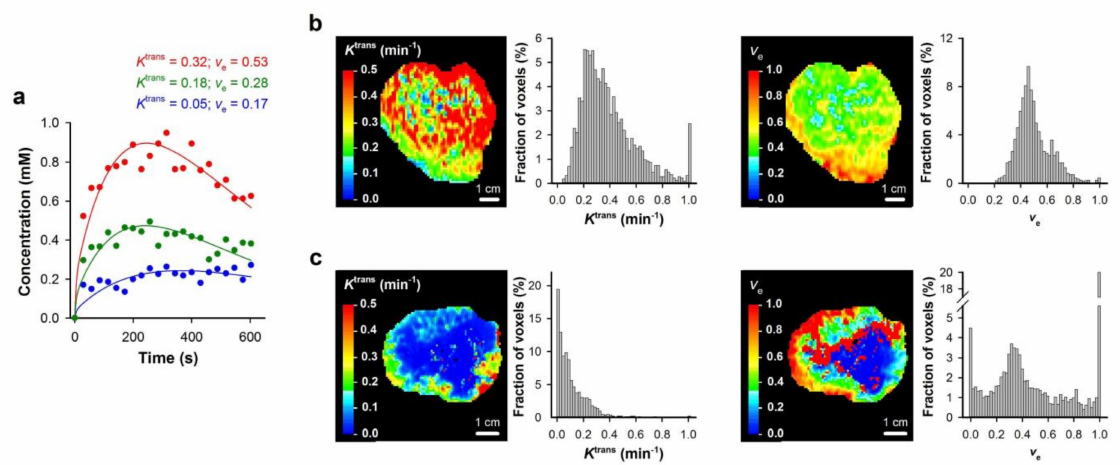
Figure 8. DCE-MRI series of human tumors were analyzed on a voxel-by-voxel basis by using Tofts standard pharmacokinetic model and a population-based arterial input function. ( a ) Plots of Gd-DTPA concentration versus time and the corresponding pharmacokinetic model fits for individual voxels. ( b , c ) K trans image, K trans frequency distribution, v e image, and v e frequency distribution of locally-advanced cervical carcinoma in two representative patients. Modified from Lund et al. [33].